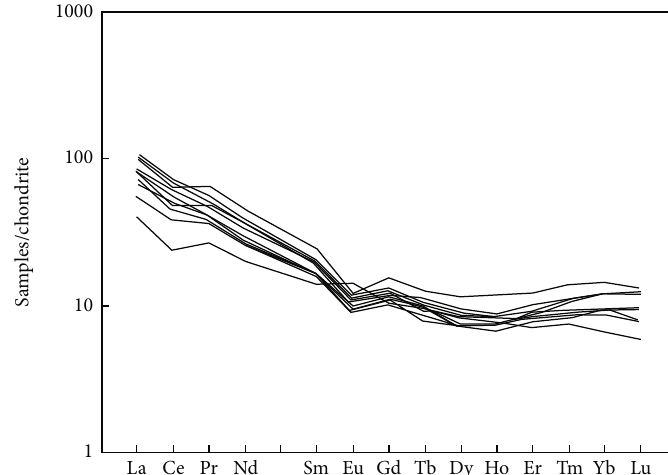
Figure 9: The chondrite-normalized REE patterns in shale samples of the fi rst member of Luzhai Formation in Rongshui area.